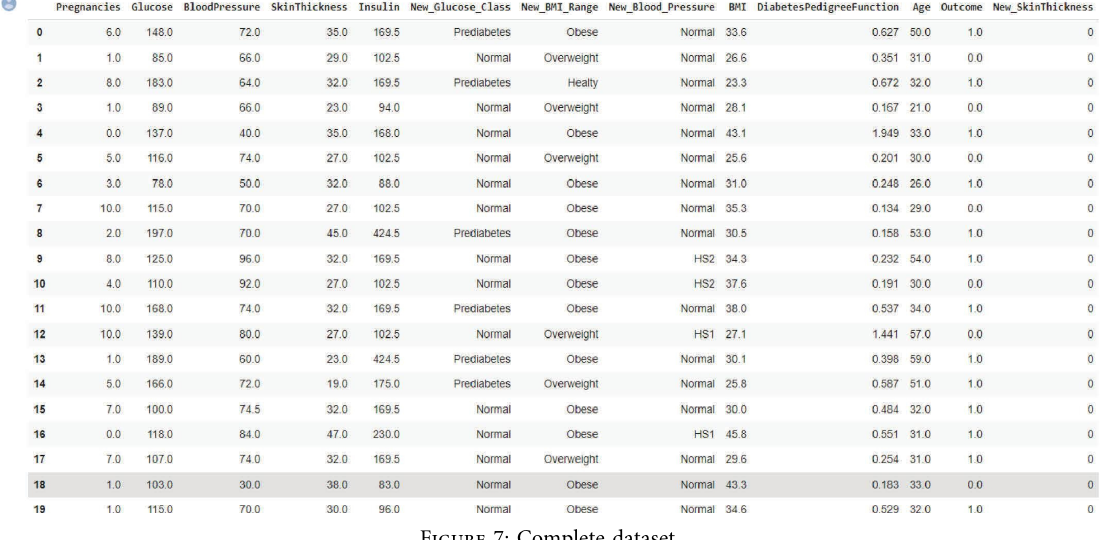
Figure 7: Complete